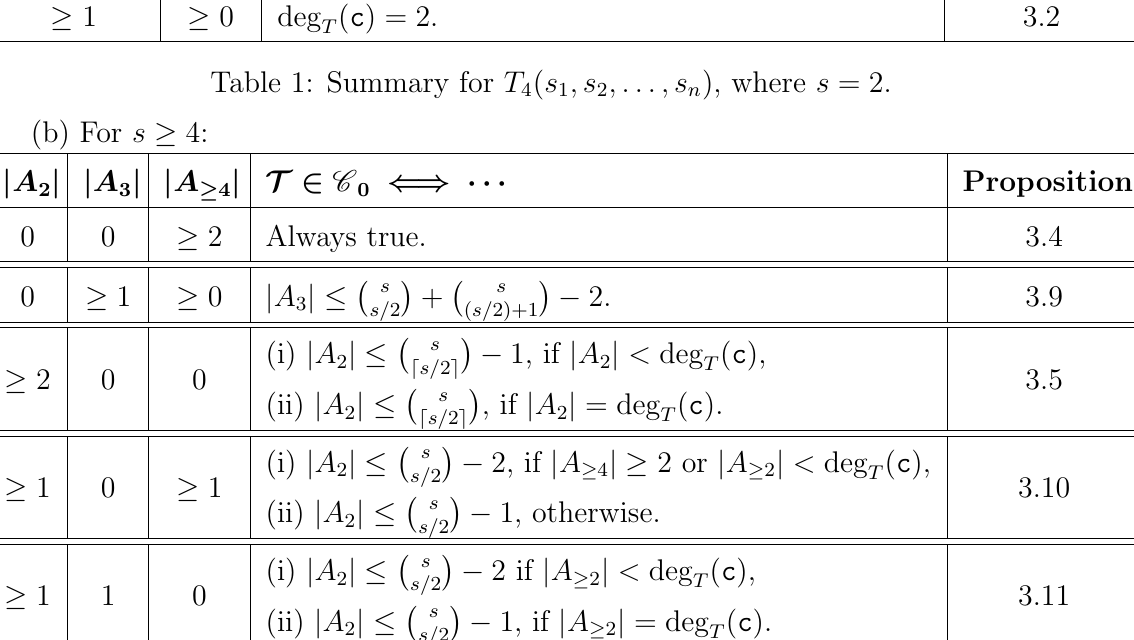
Table 1: Summary for T